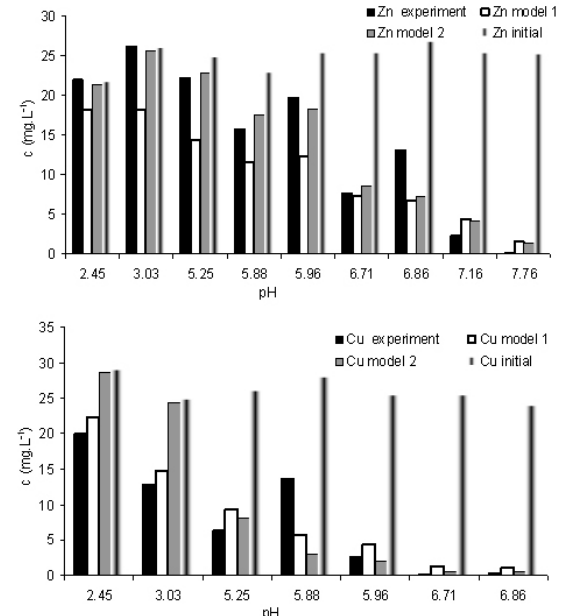
Figure 5. Results of models calculations in comparison with the experiments (competitive adsorption); Calculations were carried out using the data disclosed in Table 3 , without any